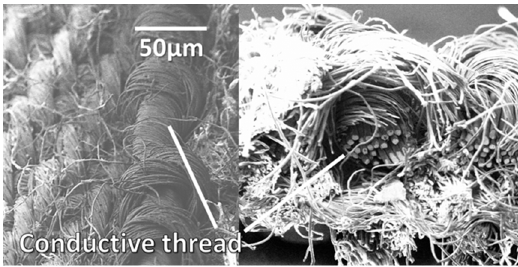
Figure 2. Scanning electron microscope (SEM) image of the surface ( left ) and cross-section ( right ), showing the conductive Litz wires, of the antenna.